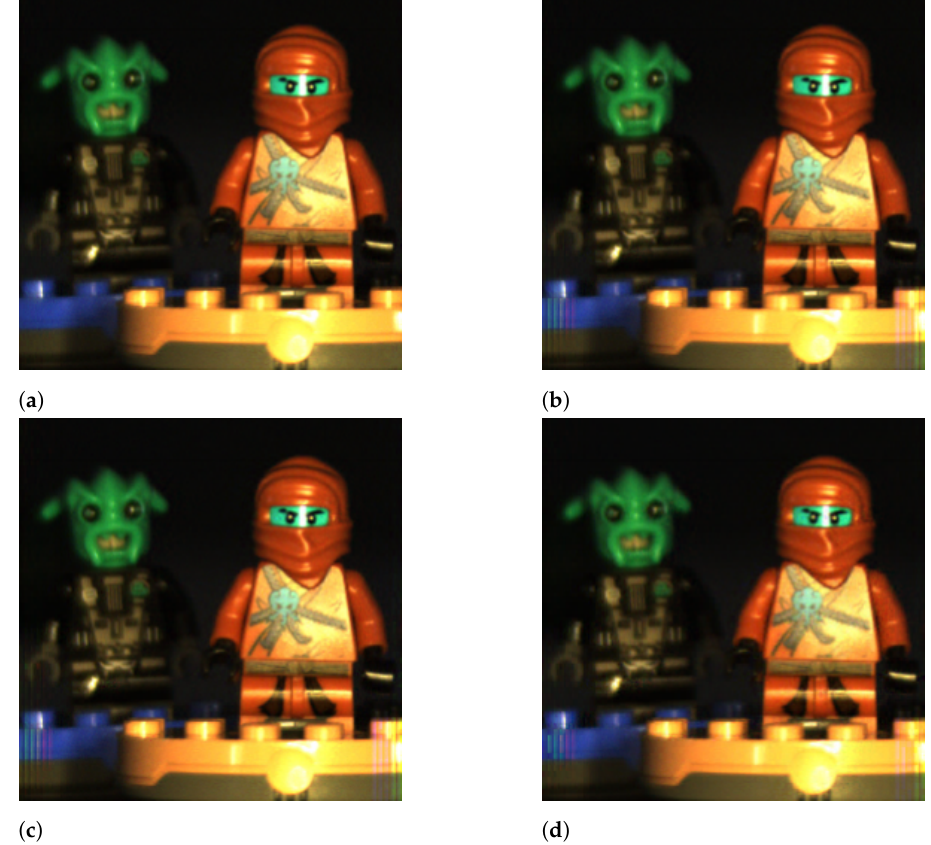
Figure 12. ( a ) Original 256 × 256 × 24 datacube for the “Ninja” image. Reconstructions for N s = 20 shots, DCT basis, and 4 × 4 blocks using: ( b ) the LASSO algorithm (PSNR = 37.41 dB),